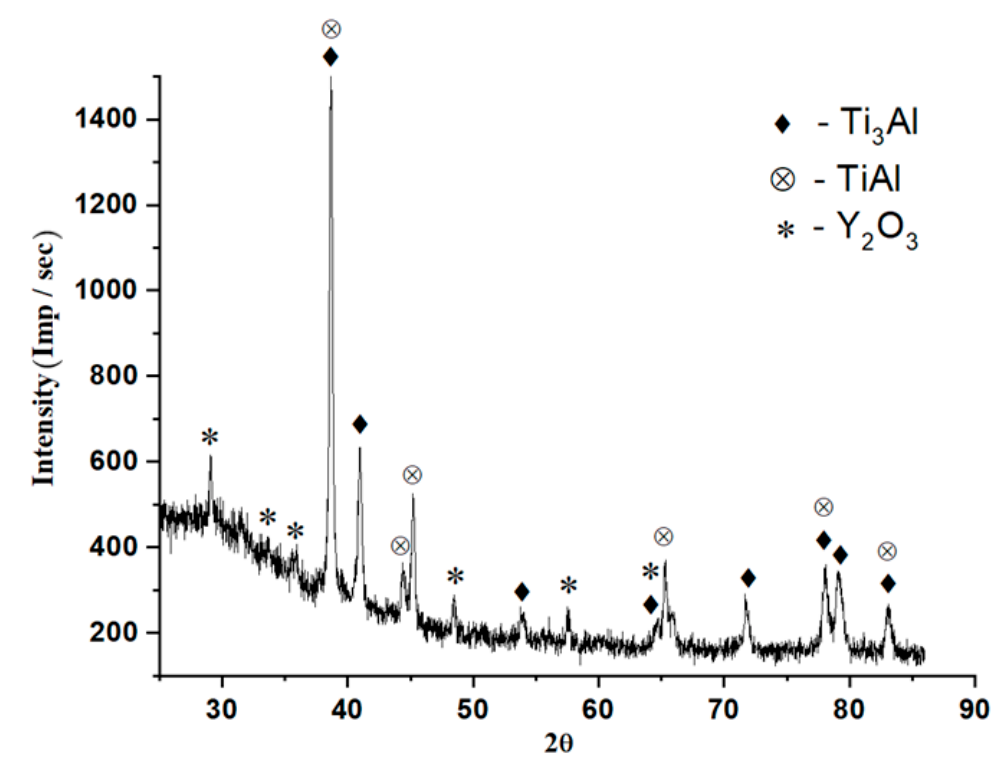
Figure 1. Diffraction patterns of the TAY alloy.